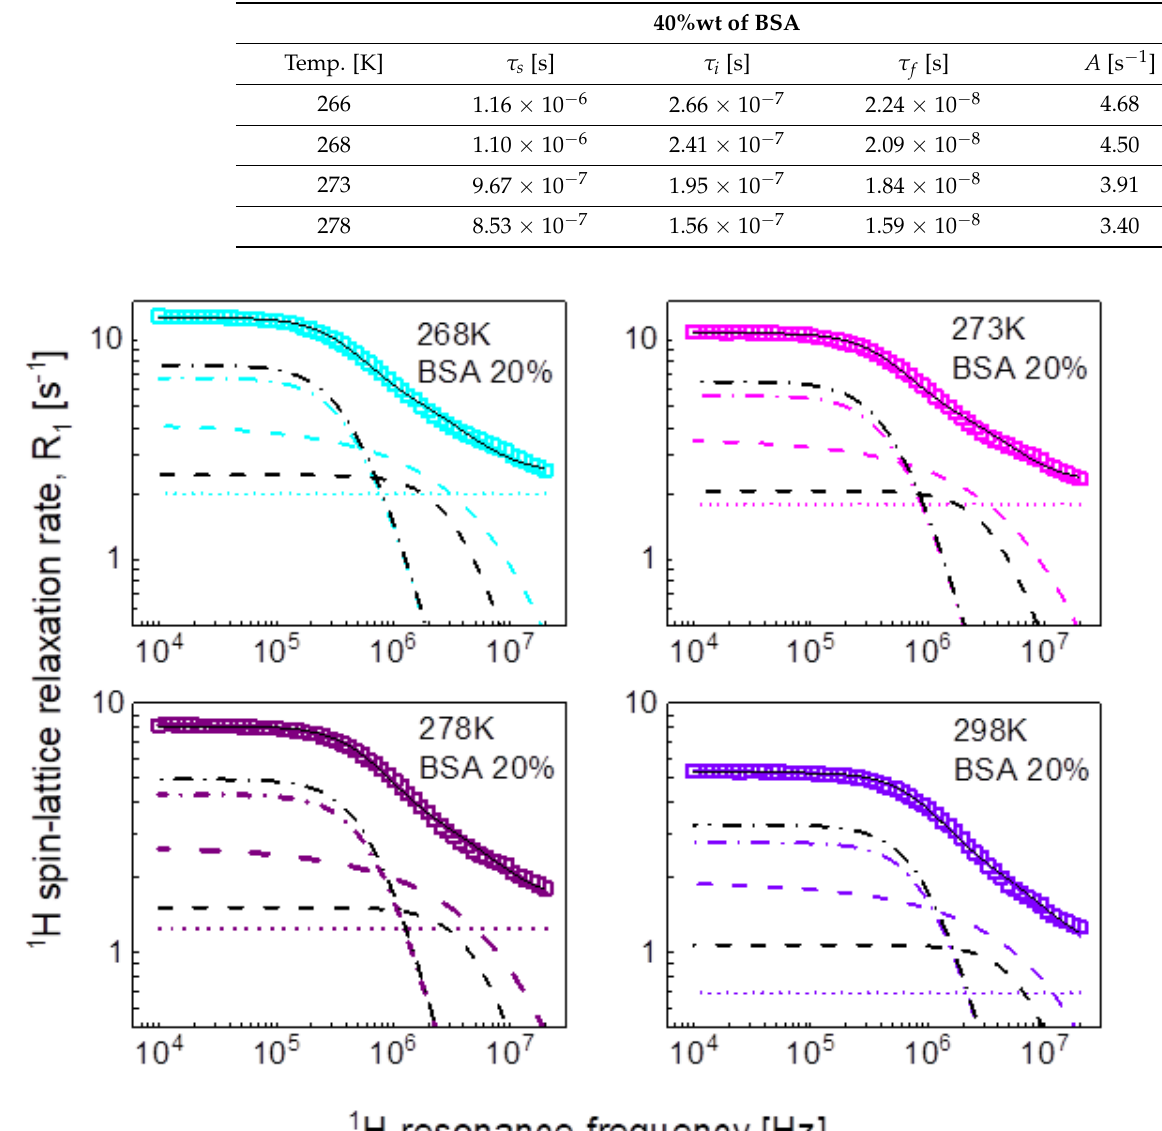
Figure 3. 1 H spin-lattice relaxation data for BSA–water mixture (20%wt of BSA) reproduced in terms of Equation (3); black solid line—overall fit decomposed into a contribution associated with intermediate dynamics (dashed-dotted black line) and fast dynamics (dashed black line), there is no relaxation contribution associated with slow dynamics. Comparison fits obtained in terms of Equation (5) are shown as the corresponding color lines (the lines are hardly visible as they almost overlap with the black ones), they are decomposed into Lorentzian term (dashed-dotted line), a term associated with three-dimensional translation diffusion (dashed line) and frequency independent term (dotted line). Table 1. Parameters obtained from the analysis of 1 H spin-lattice relaxation data for BSA – water mixtures at higher temperatures (268 K and above) in terms of Equation (1). The dipolar relaxation constants, 𝐶 𝑖𝐷𝐷 and 𝐶 𝑓𝐷𝐷 , for 20%wt concentration of BSA yields: 𝐶 𝑖𝐷𝐷 = 7.84 × 10 6 Hz 2 , 𝐶 𝑓𝐷𝐷 = 2.16 × 10 7 Hz 2 . The dipolar relaxation constants for 40%wt concentration of BSA are: 𝐶 𝑠𝐷𝐷 = 5.61 × 10 6 Hz 2 , 𝐶 𝑖𝐷𝐷 = 1.45 × 10 7 Hz 2 and 𝐶 𝑓𝐷𝐷 = 9.89 × 10 7 Hz 2 .